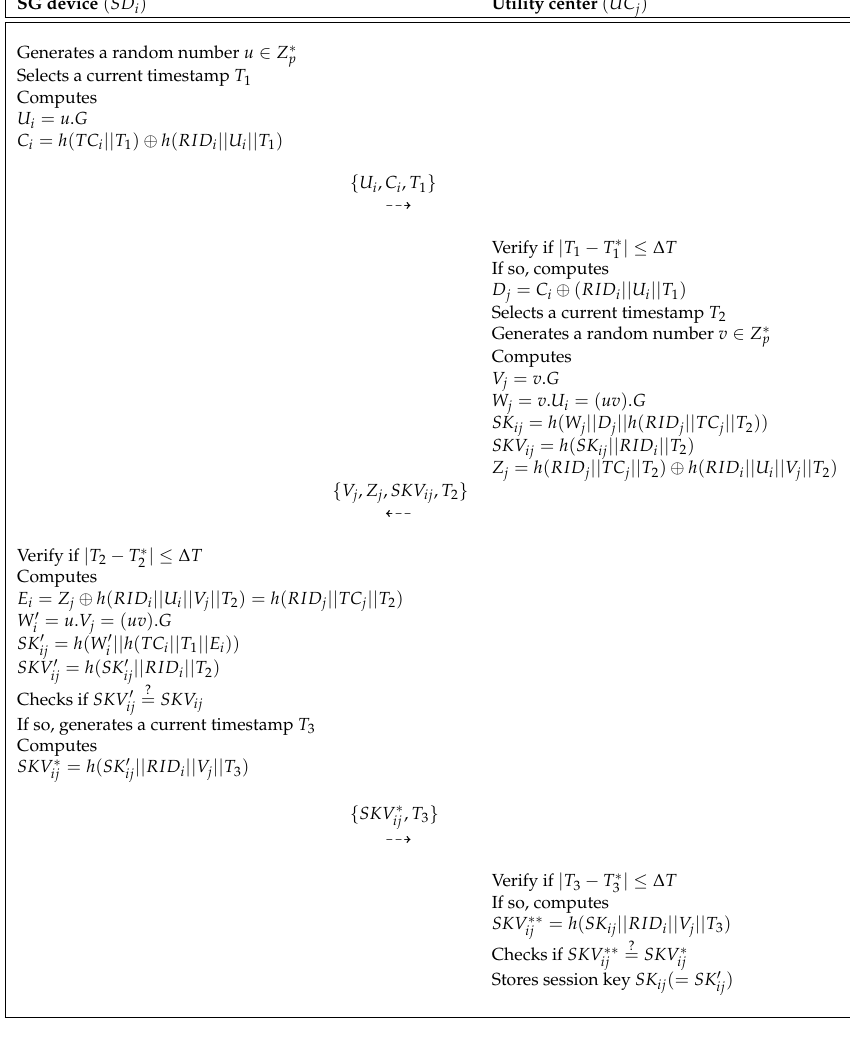
Figure 5. Authentication process of Kumar et al.’s